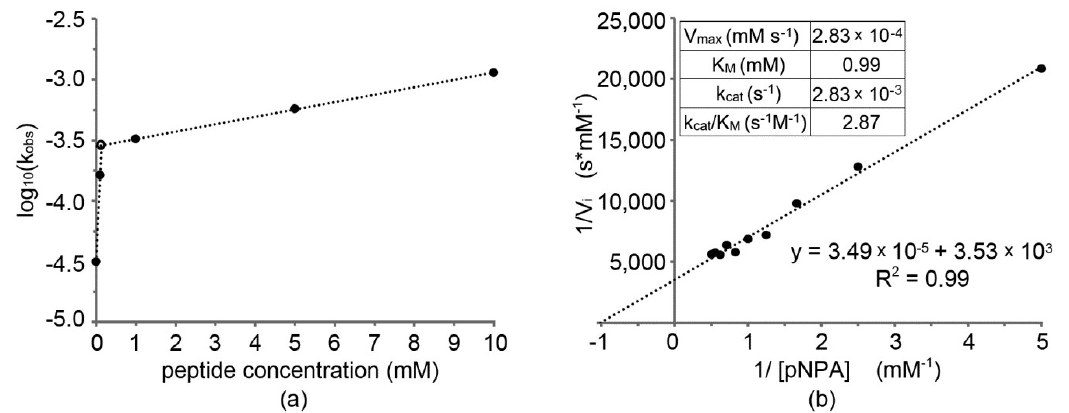
Figure 3. ( a ) Log 10 (k obs ) against peptide concentration; ( b ) Lineweaver–Burk plot with catalytic parameters (inset).